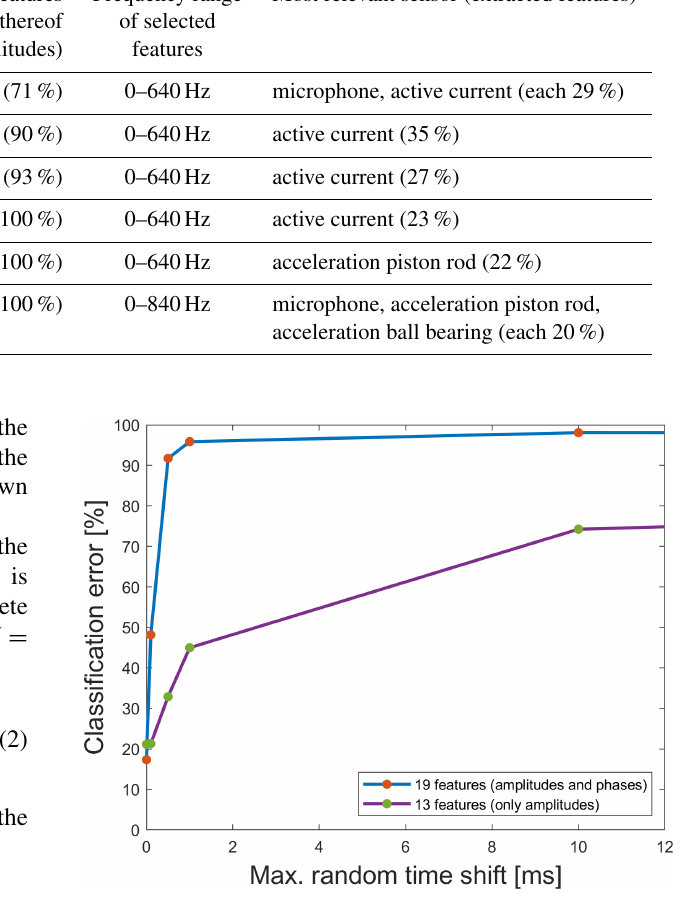
Figure 13. Classification error for one fold of the 10-fold cross val- idation using the raw data set for the model training and applying this model to data sets with different maximum random time shifts. Red dots represent models based on both amplitude and phase fea- tures, while green dots represent models using amplitude data